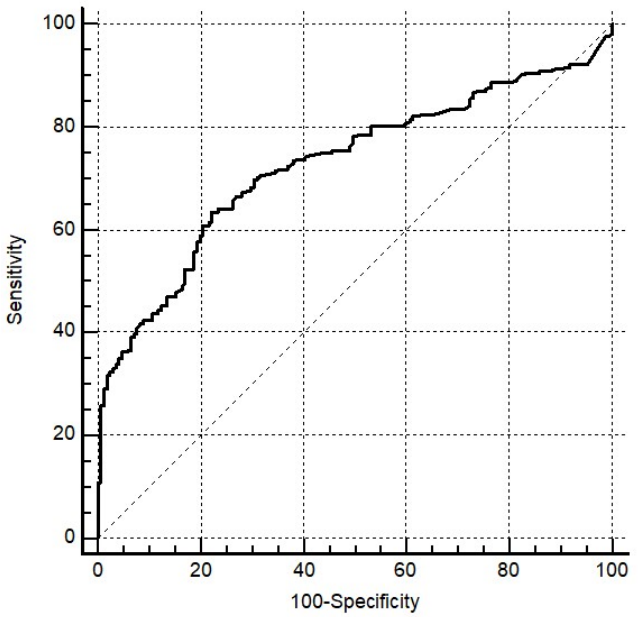
Figure A1. Receiver-operating characteristic curve analysis of PR3-ANCA measurements by a third- generation ELISA using 309 patients with primary sclerosing cholangitis as a disease cohort (positive criterion) and 51 patients with primary biliary cholangitis as well as 120 blood donors as a control cohort (negative criterion). The area under the curve was 0.727 (95% confidential interval: 0.683–0.772, p < 0.0001).